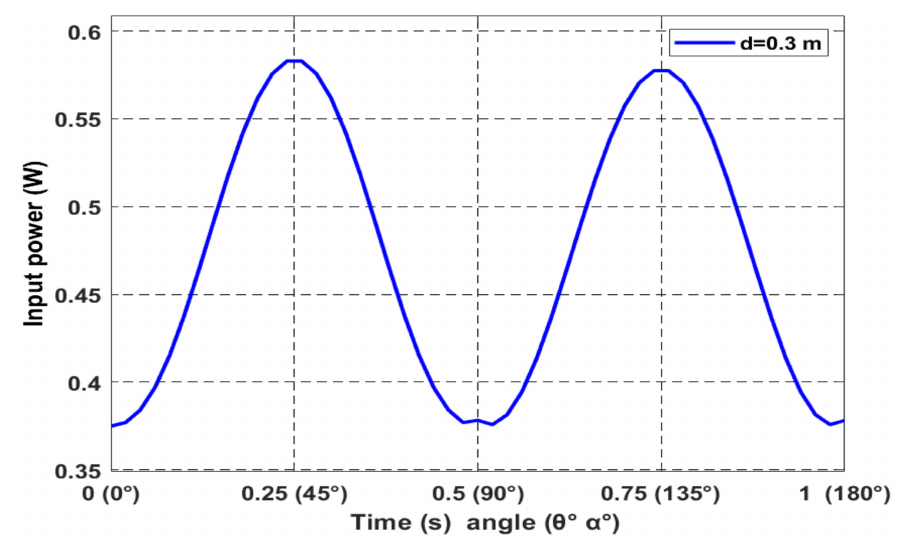
Figure 10. Input power variation versus time when θ ◦ ( t ) = α ◦ ( t )